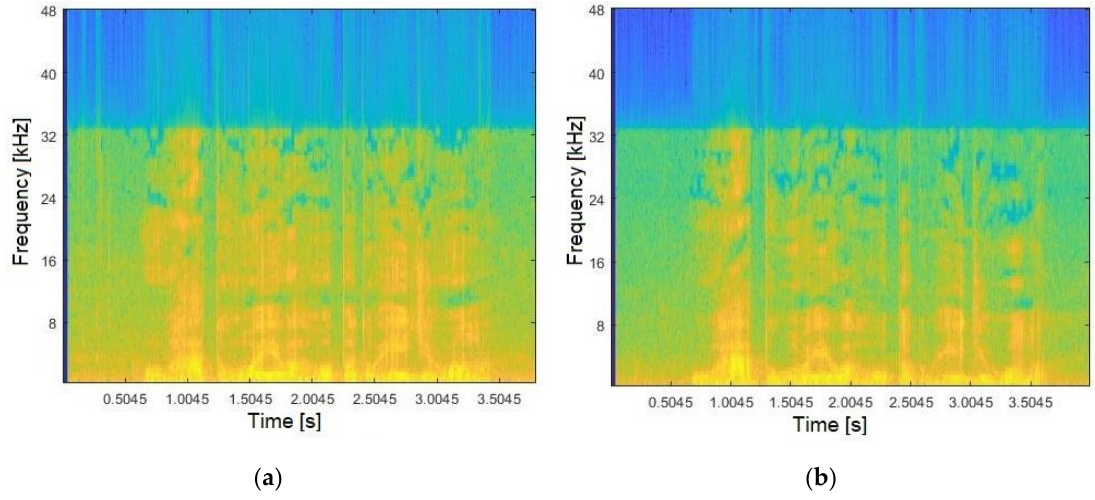
Figure 4. Audio frequency spectrum for: ( a ) confronted; ( b ) reference.